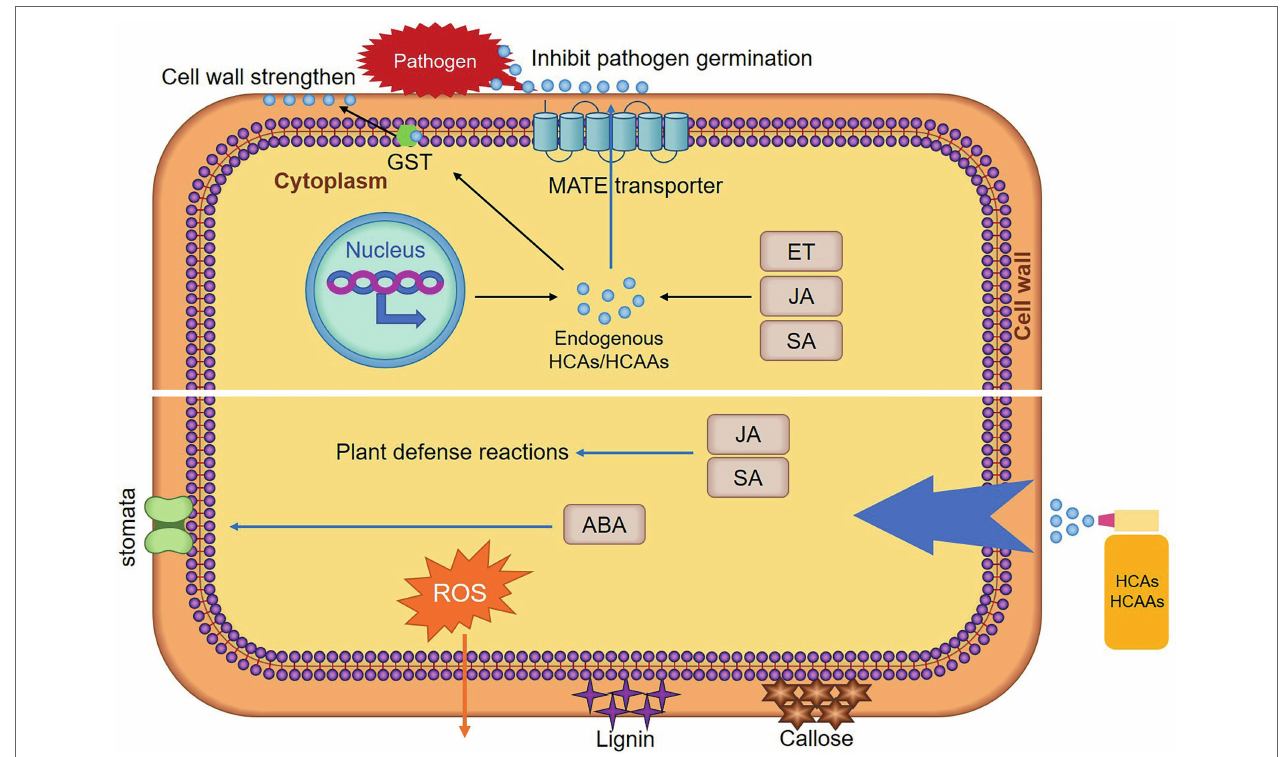
FIGURE 2 | Mechanisms of HCAs/HCAAs enhancing plant resistance. After pathogen infection, elevation of plant endogenous hormones stimulates the production of HCAs/HCAAs. Rapid transcriptional reprogramming of genes encoding biosynthetic enzymes for HCAAs is one of the mechanisms of plant defense responses. Glutathione S-transferase (GST) may act as an amide carrier protein for HCAAs translocation to the plasma membrane, then deposited on the cell wall. Under the action of MATE, HCAAs move to the leaf surface, thereby inhibiting spore germination. Exogenous HCAs/HCAAs treatment stimulated a series of plant immune responses, such as plant hormones (JA, SA, and ABA) levels are elevated, SA and JA stimulate resistance responses in plants. HCAs/HCAAs stimulated stomata opening and closing, which may be achieved by controlling the content of ABA. HCAs/HCAAs also stimulate the production of lignin, callose, and ROS. The stimulation of these immune responses increases the resistance of plants to